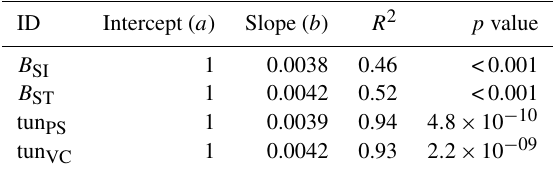
Table A6. Slopes and intercepts of biomass dose–response relation- ships for needleleaf species simulated by O-CN versions based on tuned injury functions to net photosynthesis or V cmax (see Table 1). B SI and B ST represent the simple and standard model by Büker et al.